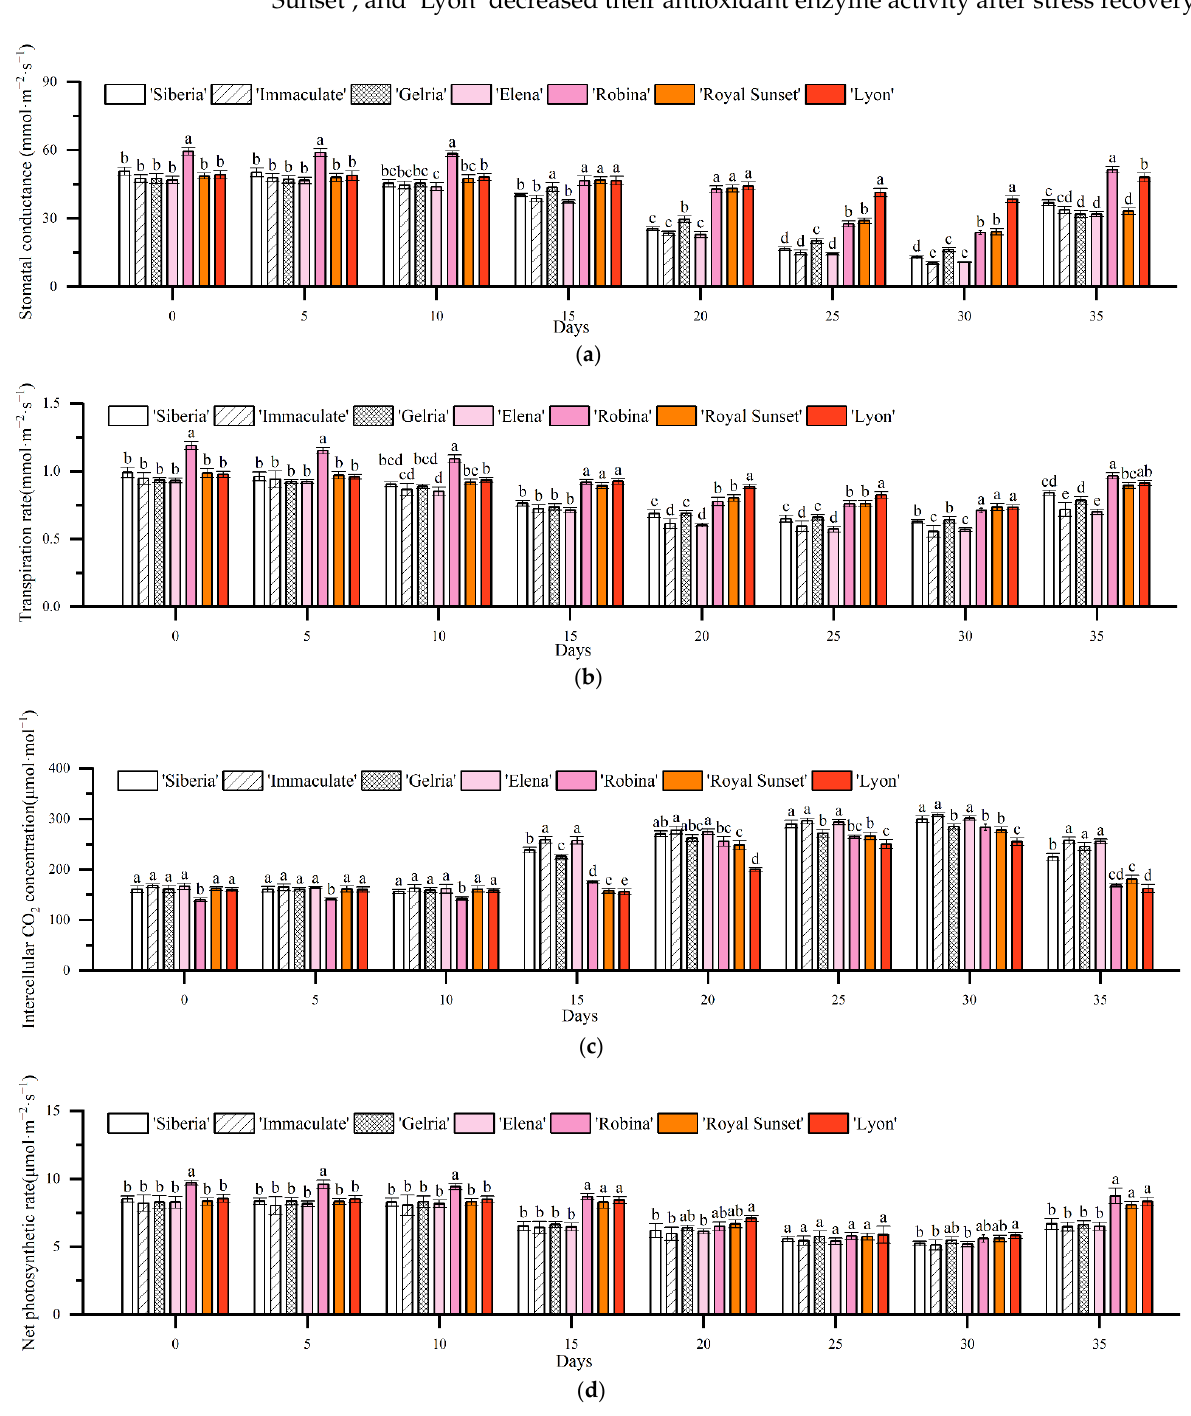
Figure 4. Effects of drought stress on chlorophyll content of lily leaves: ( a ) Effects of drought stress on chlorophyll a content; ( b ) Effects of drought stress on chlorophyll b content. Different letters above bar graphs indicate significant difference among lily varieties ( p < 0.05, n = 3).